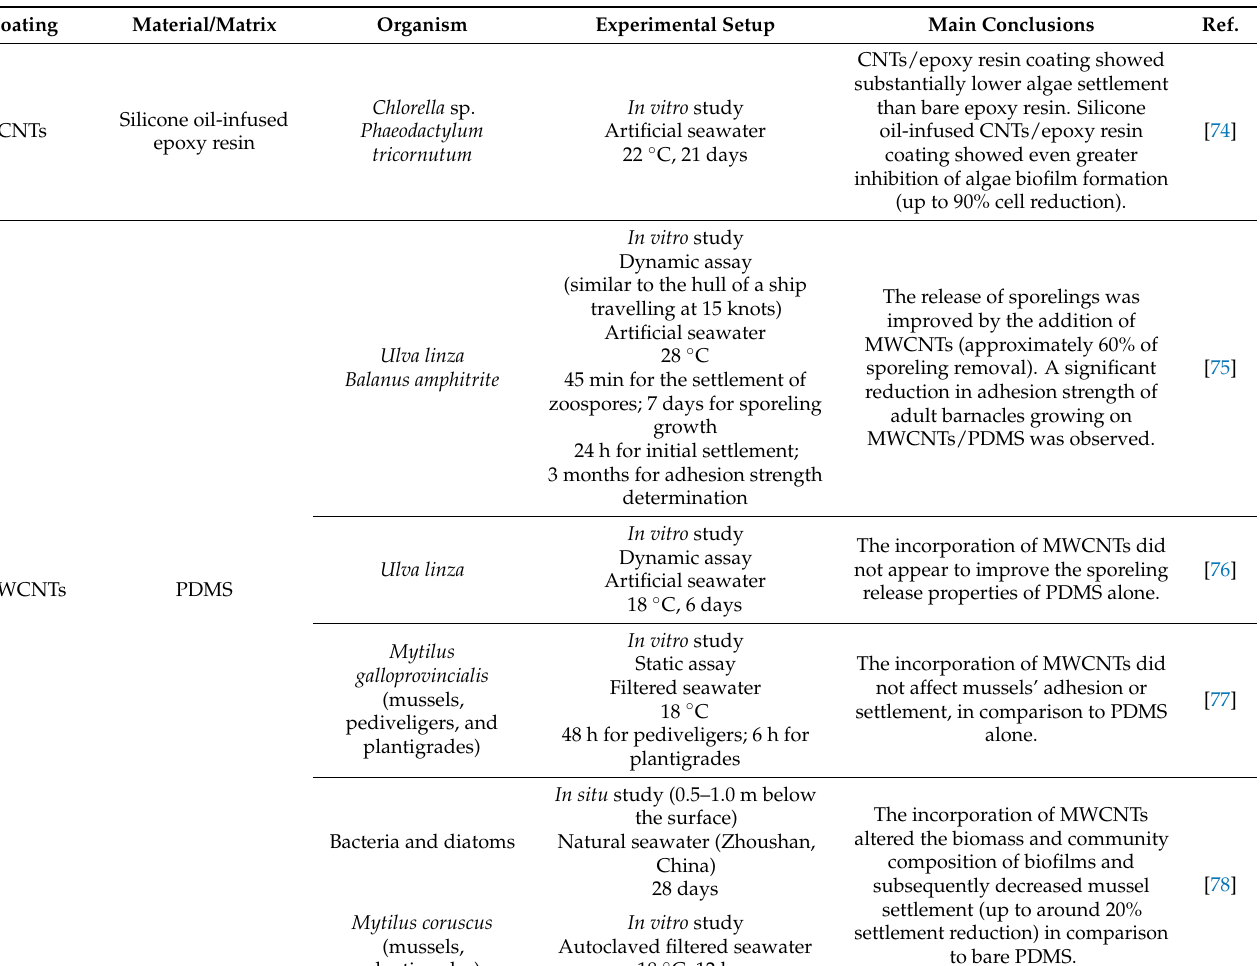
Table 2. Studies focused on CNT-based AF coatings in marine